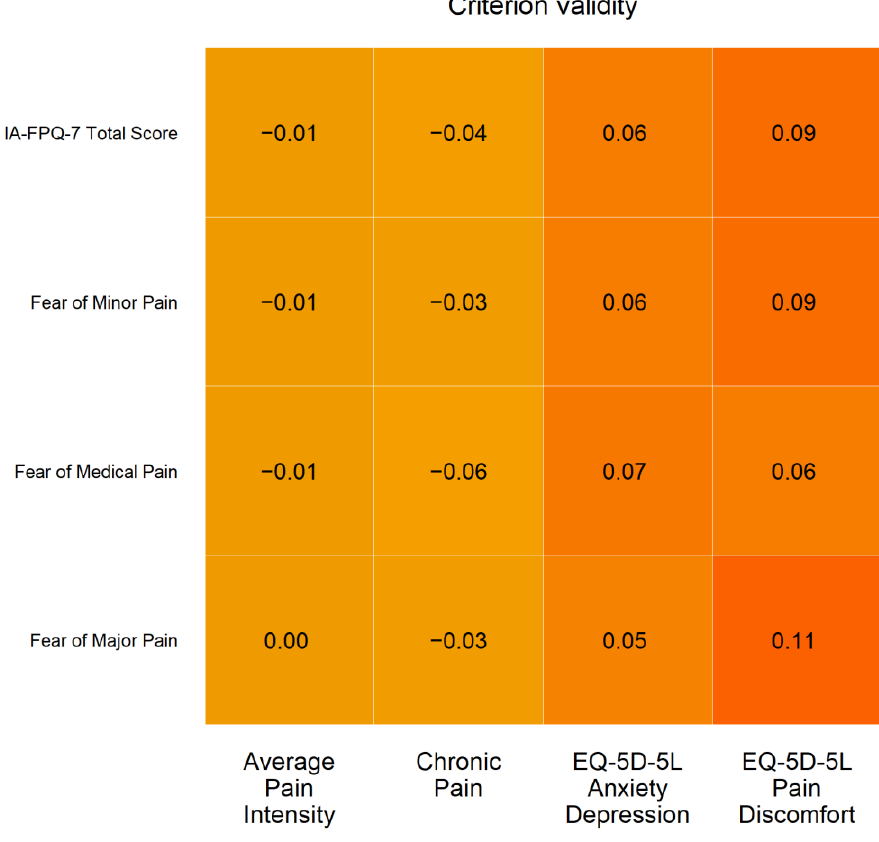
Figure 4. Criterion validity of the IA-FPQ-7. Note: The saturation of the colour indicates the strength of the correlation (i.e., stronger shades of orange indicate stronger correlations).